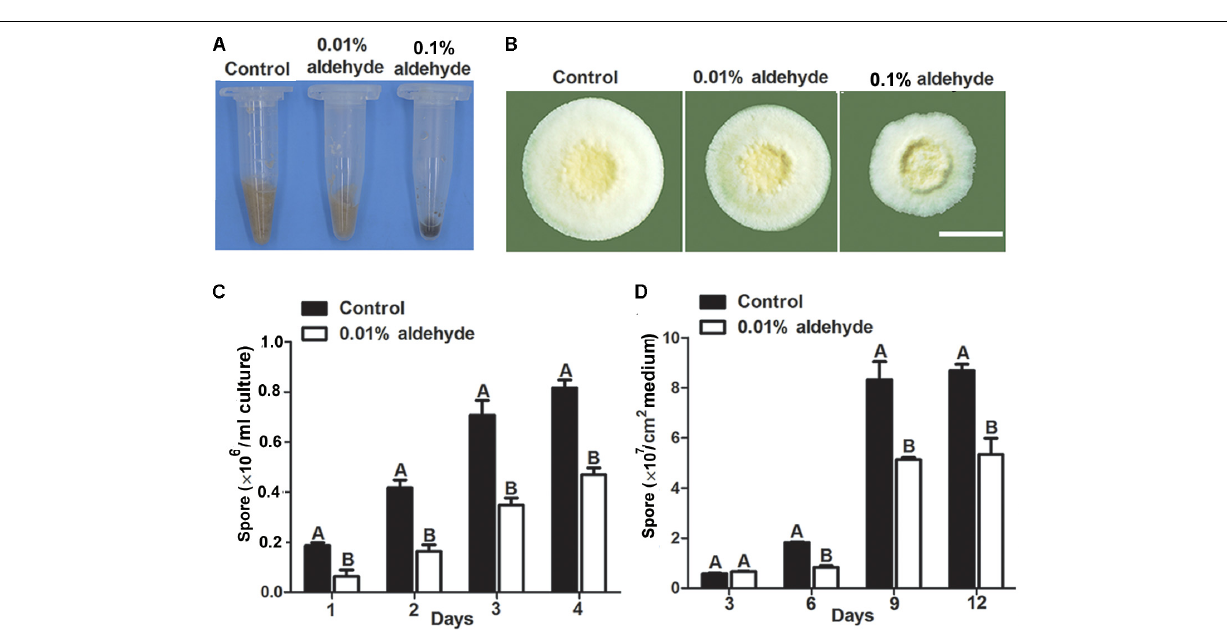
FIGURE 6 | Effect of aldehyde on conidiation under normal condition. (A) Sporulation in the 1/4 SDA liquid culture medium containing aldehyde (B) Conidiation on 1/4 SDAY solid medium with aldehyde. (C) Sporulation quantification in liquid medium with 0.01% aldehyde (D) Sporulation quantification on solid medium with 0.01% aldehyde. All experiments were repeated at least three times. Error bars, SD. A, B indicate significant difference at p <